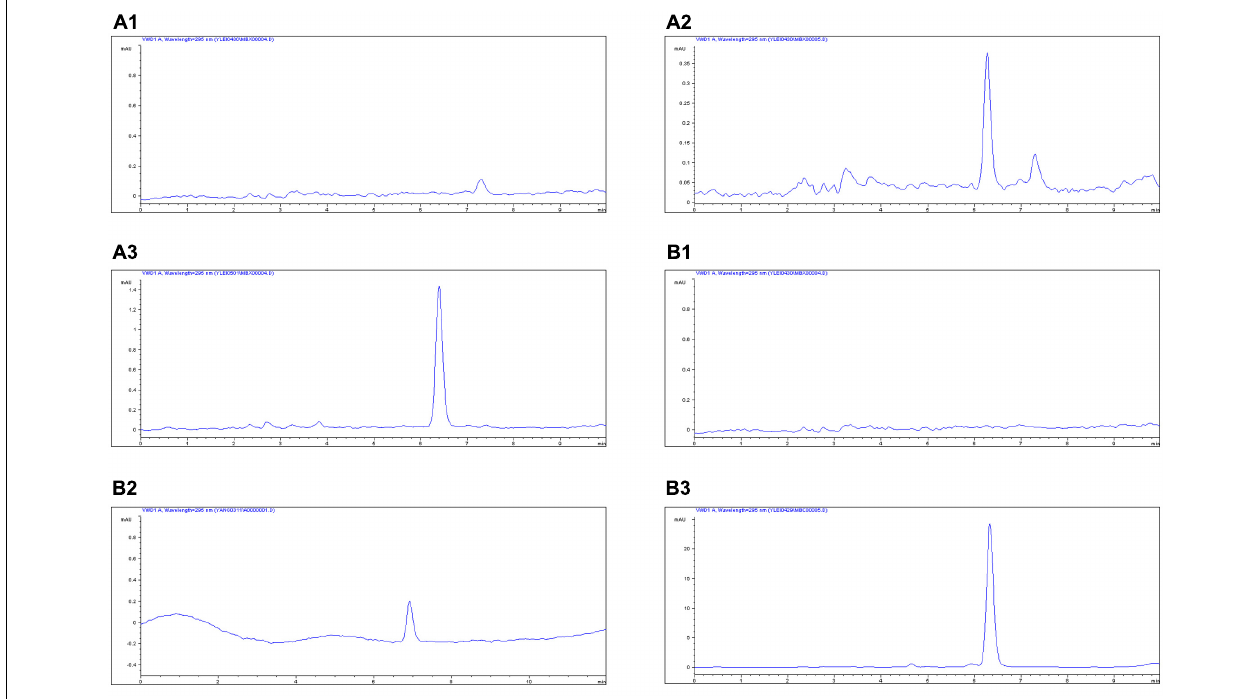
FIGURE 4 | The HPLC method for MBF quantification in plasma and ileum content. The representative HPLC chromatograms of plasma were shown: (A 1 ) blank sample, (A 2 ) plasma sample at the LLOQ of 0.05 µ g/ml, (A 3 ) plasma sample after oral administration of MBF at the point of 1 h; the representative HPLC chromatograms of ileum content were shown: (B 1 ) blank sample, (B 2 ) ileum content sample at the LLOQ of 0.05 µ g/ml, (B 3 ) ileum sample after oral administration of MBF at the point of 1 h, the MBF at the retention time of 6.5